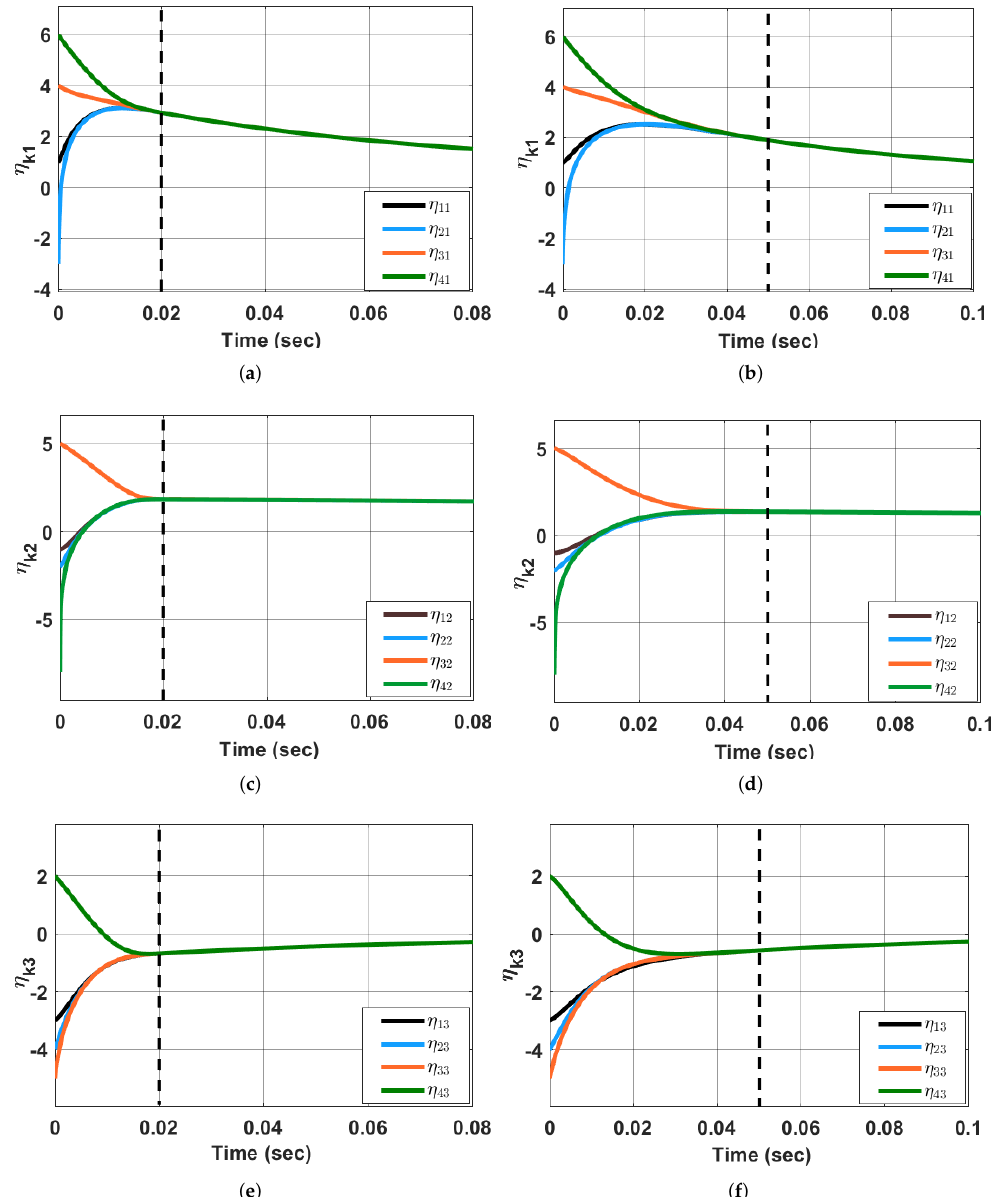
Figure 2. Synchronization of the states of MAS (1) using the adaptive control (32) and (44) (with ζ ( t ) = 0) in predefined-time τ f = 0.02 s ( a , c , e ) and τ f = 0.05 s ( b , d , f